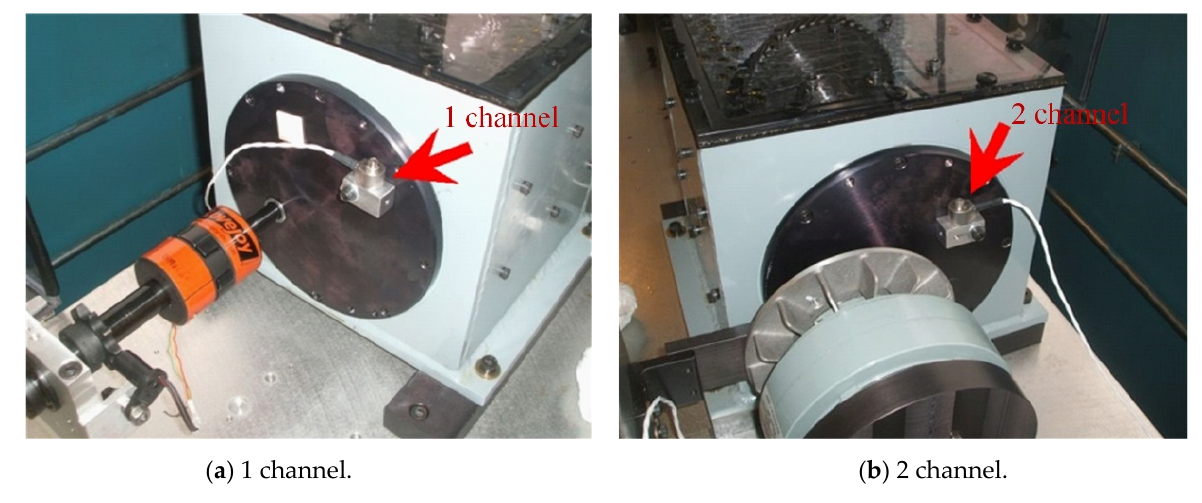
Figure 9. Accelerometers installation location.